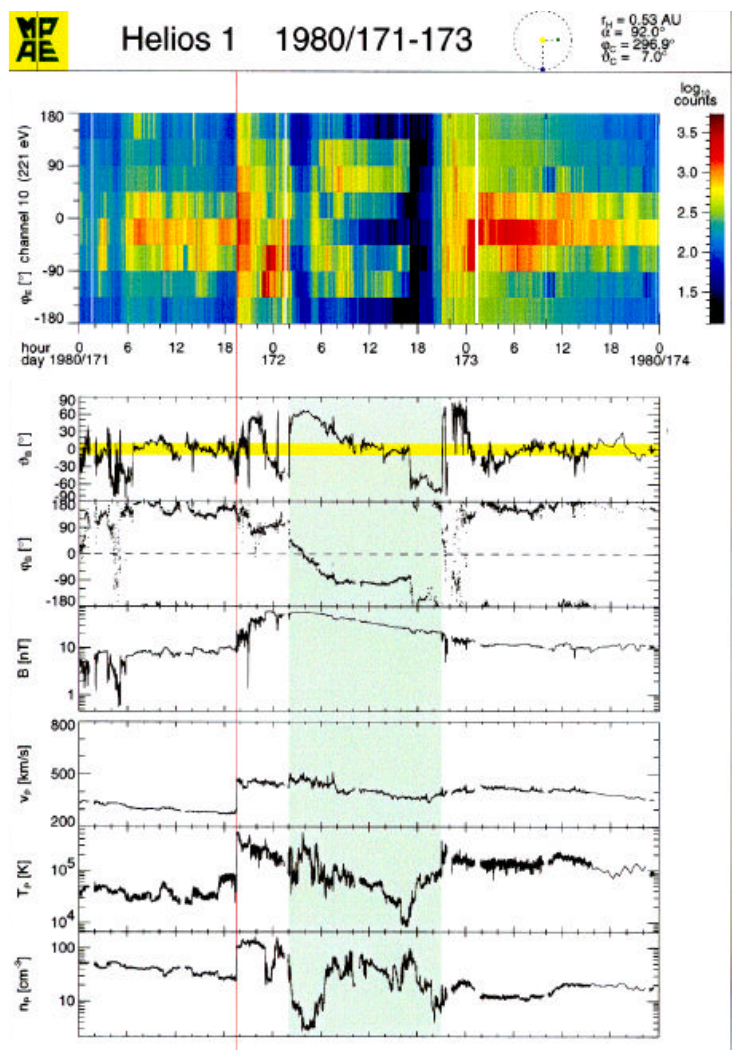
Fig. 3. The events associated with the interplanetary shock wave of 19 July 1980, as observed by the Helios 1 spaceprobe from a position at 0.53 AU distance to the Sun and at 92 ◦ west of the Earth-Sun line, i.e. right above the Sun’s west limb as seen from the Earth. The 6 bottom panels show (from top) the IMF north-south ( θ B ) and east-west ( φ B ) direction, the field magnitude, and the solar wind speed, temperature and density. The upper panel shows the azimuthal flow angle φ E of suprathermal electrons (221 eV), with the anti-Sun direction at 0 ◦ . This is one of the cases for which Sheeley et al. (1985) could find a uniquely correlated CME. Figure courtesy of Kevin Ivory, MPS.